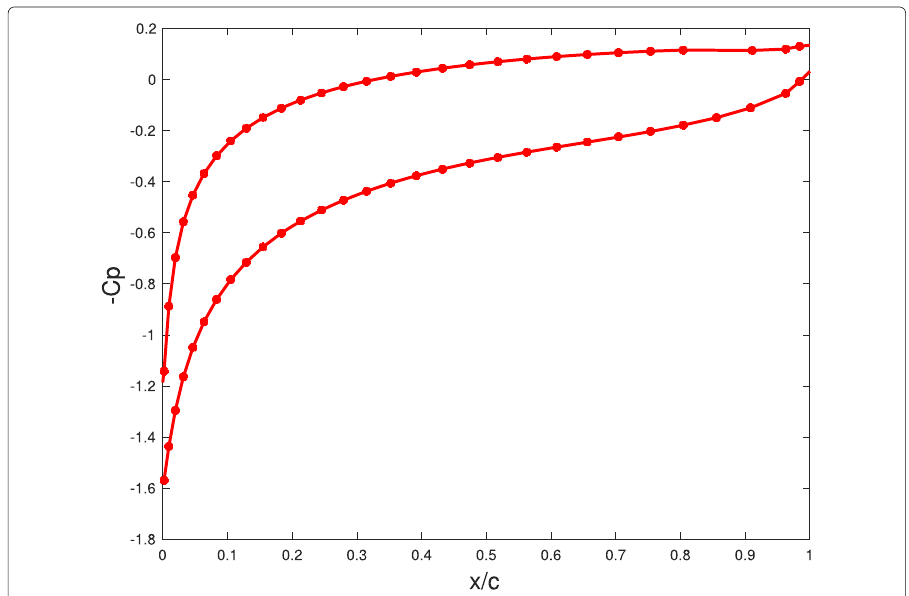
which usually occurs at an interface between two fluids with different densities when the acceleration is directed from the heavy fluid to the light fluid, see [35, 36] for a detailed description of this phenomenon. We take the computational domain as [ 0, 0.25] × [ 0, 1]. The initial solution is (cid:25) ( 2, 0, − 0.025 a cos ( 8 π x ) , 1 + 2 y ) , y ∈ ( 0, 0.5 ) , (ρ , u , v , p ) = ( 1, 0, − 0.025 a cos ( 8 π x ) , y + 1.5 ) , y ∈ [ 0.5, 1 ) , ! γ p γ = 5 . The Prandtl where a = ρ is the sound speed with ratio of specific heats 3 number is taken as Pr = 0.7 for this test case. An adiabatic, reflective boundary condition is imposed for the left and right boundaries. At the bottom and top boundaries, the flow values are set as (cid:25) ( 2, 0, 0, 1 ) , y = 0, (ρ , u , v , p ) = ( 1, 0, 0, 2.5 ) , y = 1, respectively. The source term ρ is added to the right hand side of the second momen- tum equation and ρ v is added to the right hand side of the energy equation in (1). All the simulations are based on a 30 × 120 background mesh till final time T = 1.95, and the ( k + 1 ) -th order IMEX-RK time discretization will be employed when P k element is used. For the NS simulations, we adopt a single indicator η gi with parameters ω 1 = 1.5, = 0.5. Computational results with Reynolds number 50000 and 150000 are shown in ω 2 Figs. 14 and 15, respectively. As can be seen, the interface between two fluids with differ- ent densities becomes thinner as the Reynolds number increases. Our adaptive methods can capture the interface and small-scale features precisely, and the resolution of P 2 ele- ment can even be comparable to that obtained with the ninth-order WENO scheme on a 600 × 2400 uniform mesh in [36]. The adaptive meshes and density contours of the Euler simulations with TVB limiter [3] and without TVB limiter are also presented in Figs. 16 and 17 by using adaptive parameters ω 1 = 1.2, ω 2 = 0.3. Due to the absence of